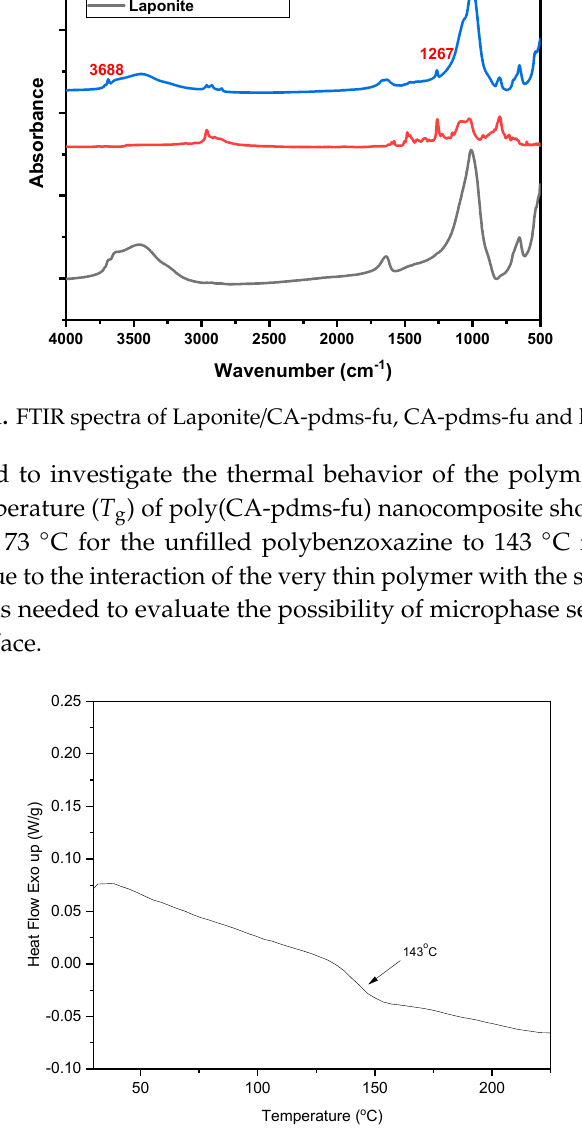
Figure 12. DSC thermogram of Laponite/poly(CA-pdms-fu).